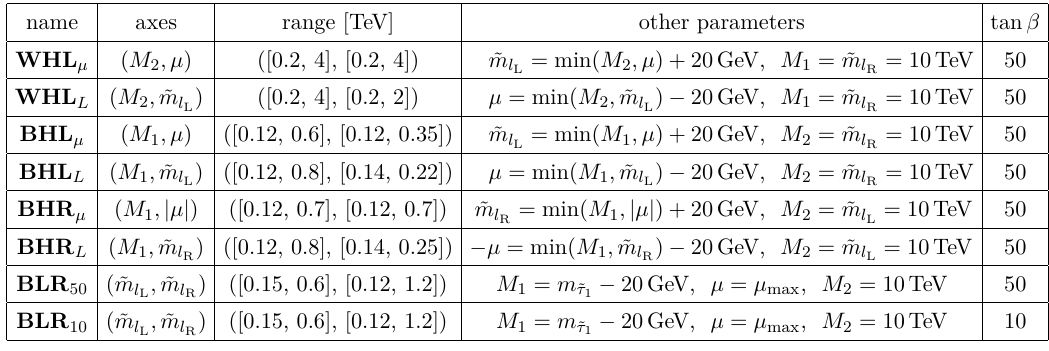
Table 1 . The parameter planes and choices of the other parameters. µ max is defined as the maximum value allowed by the vacuum stability